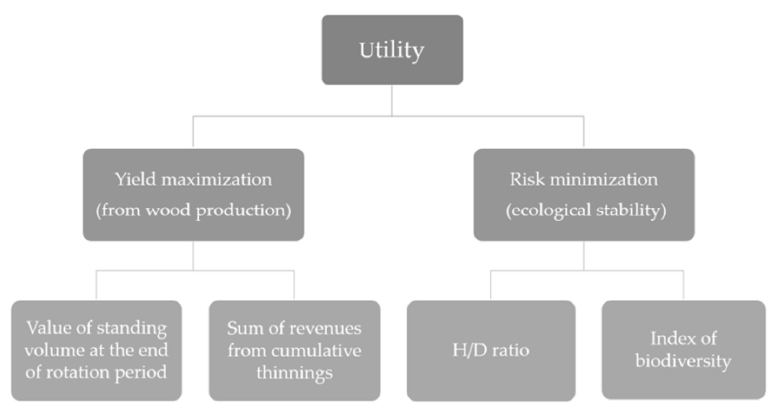
Figure 3. Goals of optimization and their indicators.